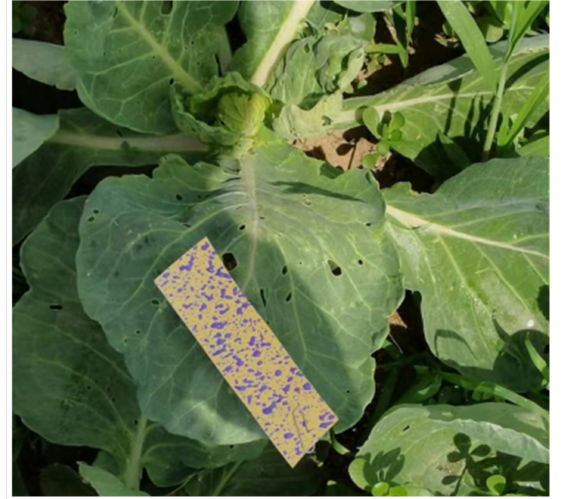
Figure 16. Photograph of spray deposition.